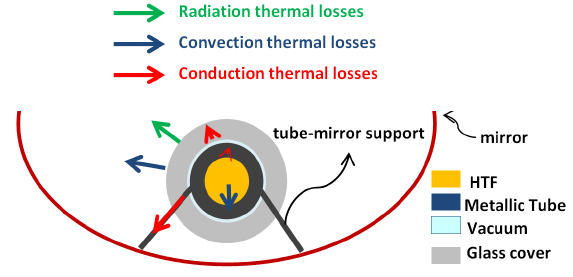
Figure 12. Thermal exchanges between solar collector elements (SCE) and surround ambient.